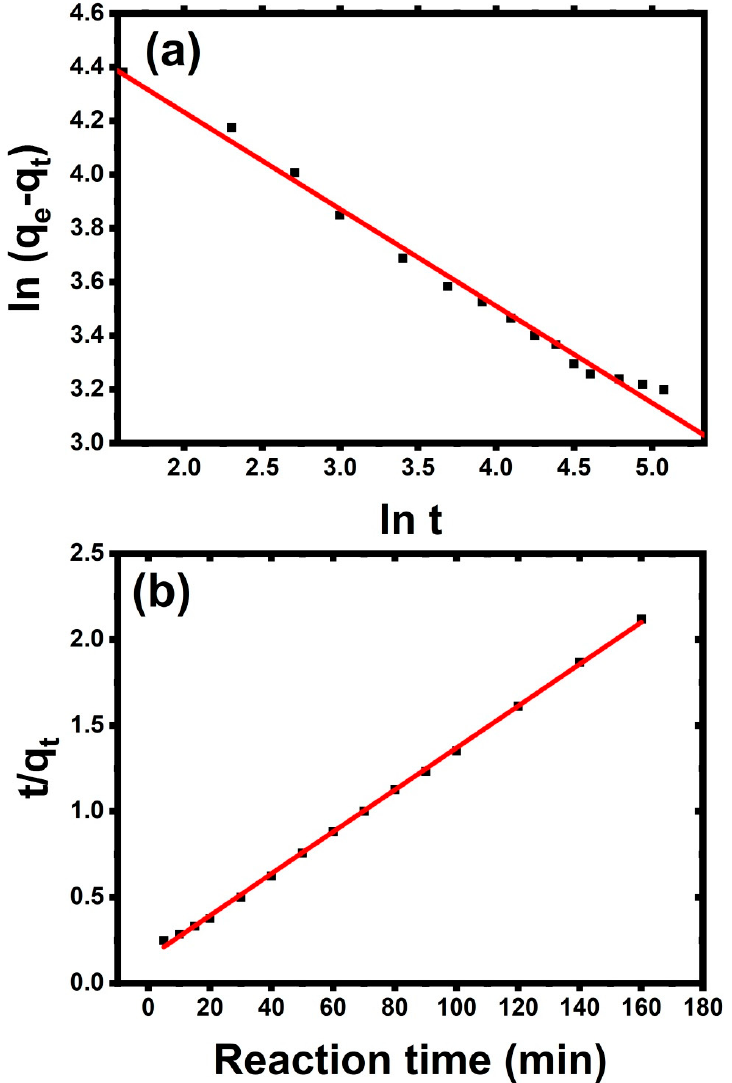
Figure 7. Adsorption kinetics of Ni(II) ions by Al 2 O 3 /PVA nanocomposite ( a ) Pseudo-first-order ( b ) and ( b ) Pseudo-second-order.